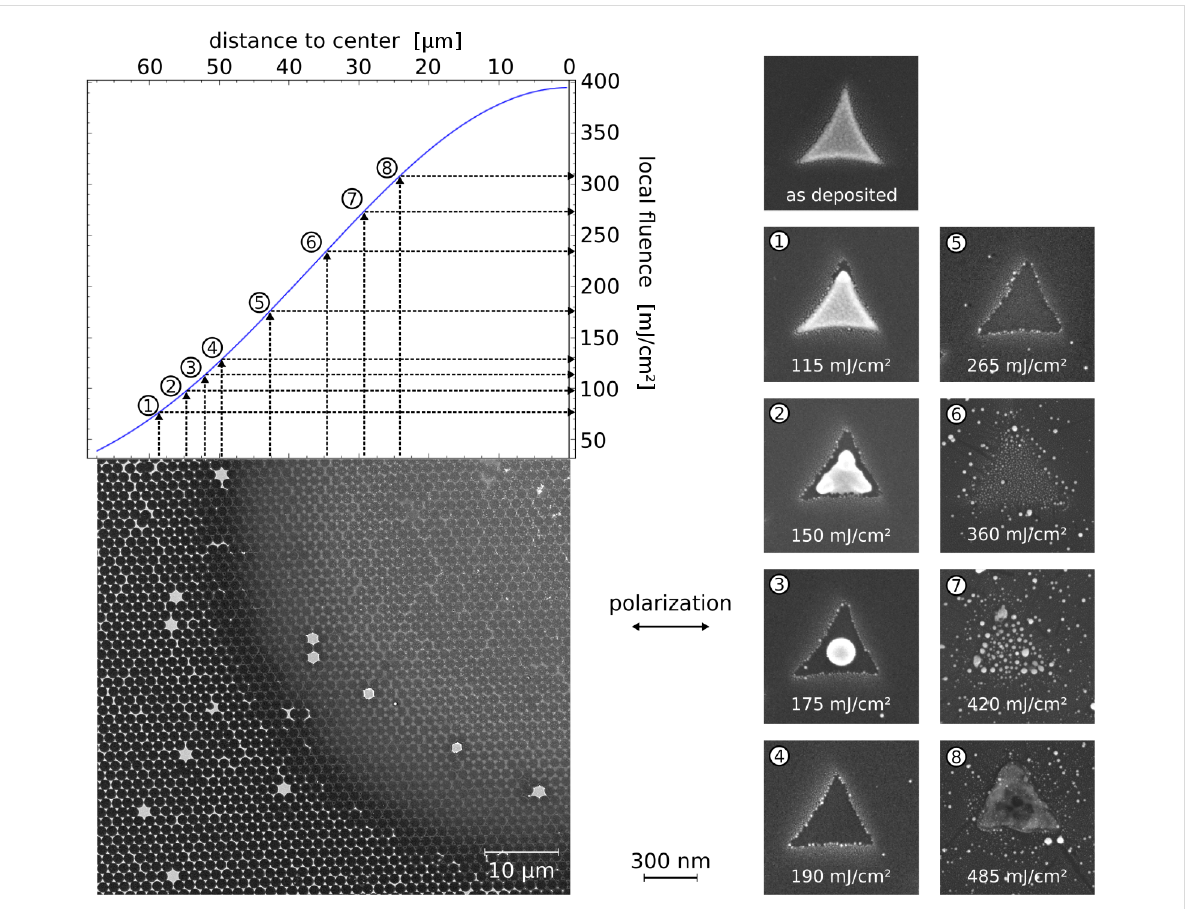
Figure 14: Evolution of laser-molten gold triangles (thickness: 40 nm, side length: 530 nm, prepared by colloid lithography with 1.55 µm diameter spheres) for increasing laser fluence in equivalent presentation as Figure 5: Upper left: Fluence distribution along the spot radius. Lower left: SEM micrograph of one quadrant of an ablation spot irradiated with a ps laser pulse (wavelength: 800 nm, FWHM: 300 ps). Right: Details at different levels of incident laser fluence. The local fluence is indicated in each